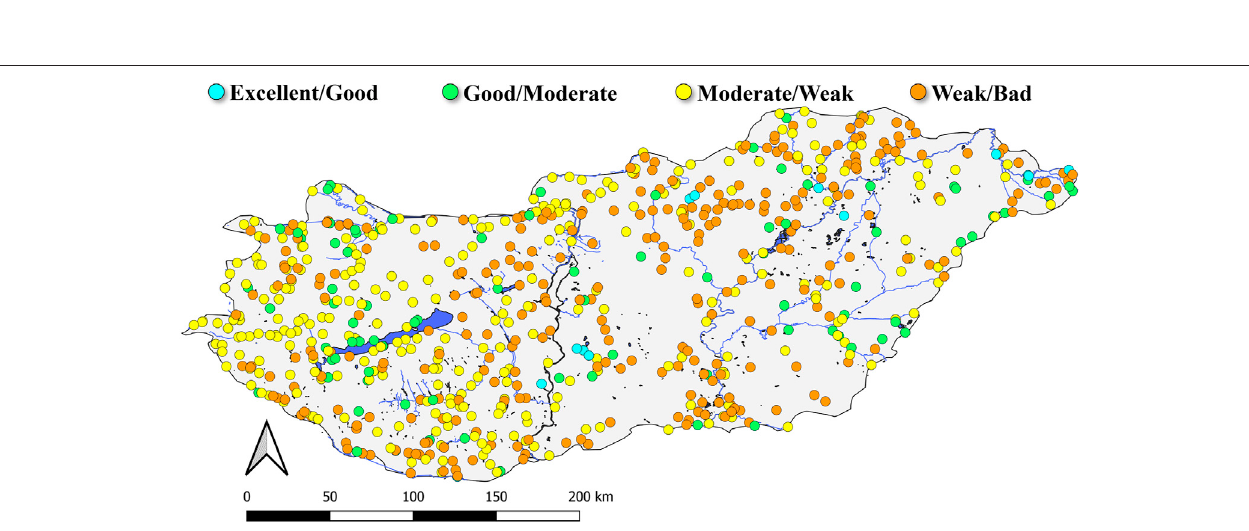
FIGURE 13 | The quality classes of water bodies based on the physical-chemical parameters in 2020.